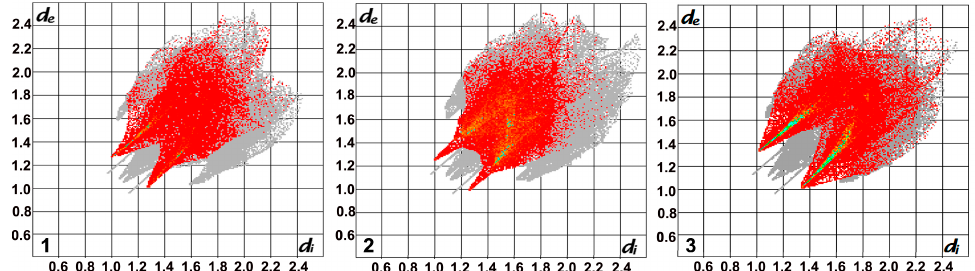
Figure 4. Fingerprint plots of the isostructural complexes 1–3 with the contribution of H ··· F/F ··· H ( 1 , 2) and H ··· O/O ··· H ( 3 ) contacts highlighted in red (grey shadows represent the full fingerprints).